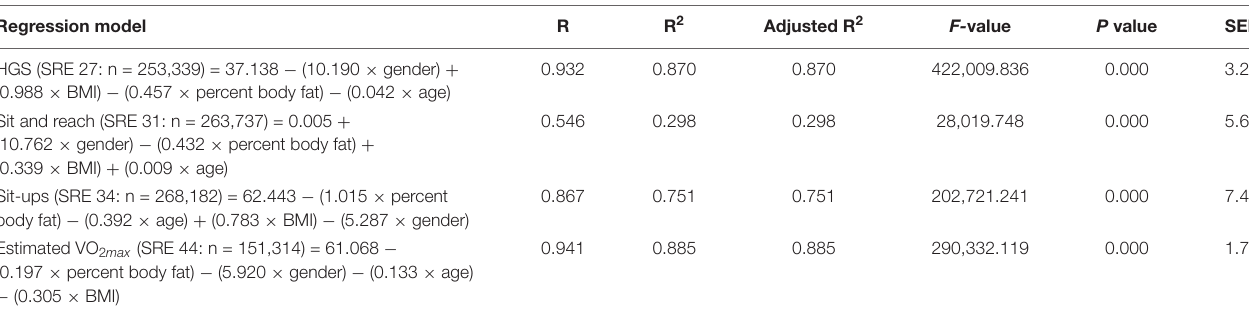
TABLE 4 | Estimated regression equations predicting HRPF parameters without outlier data.